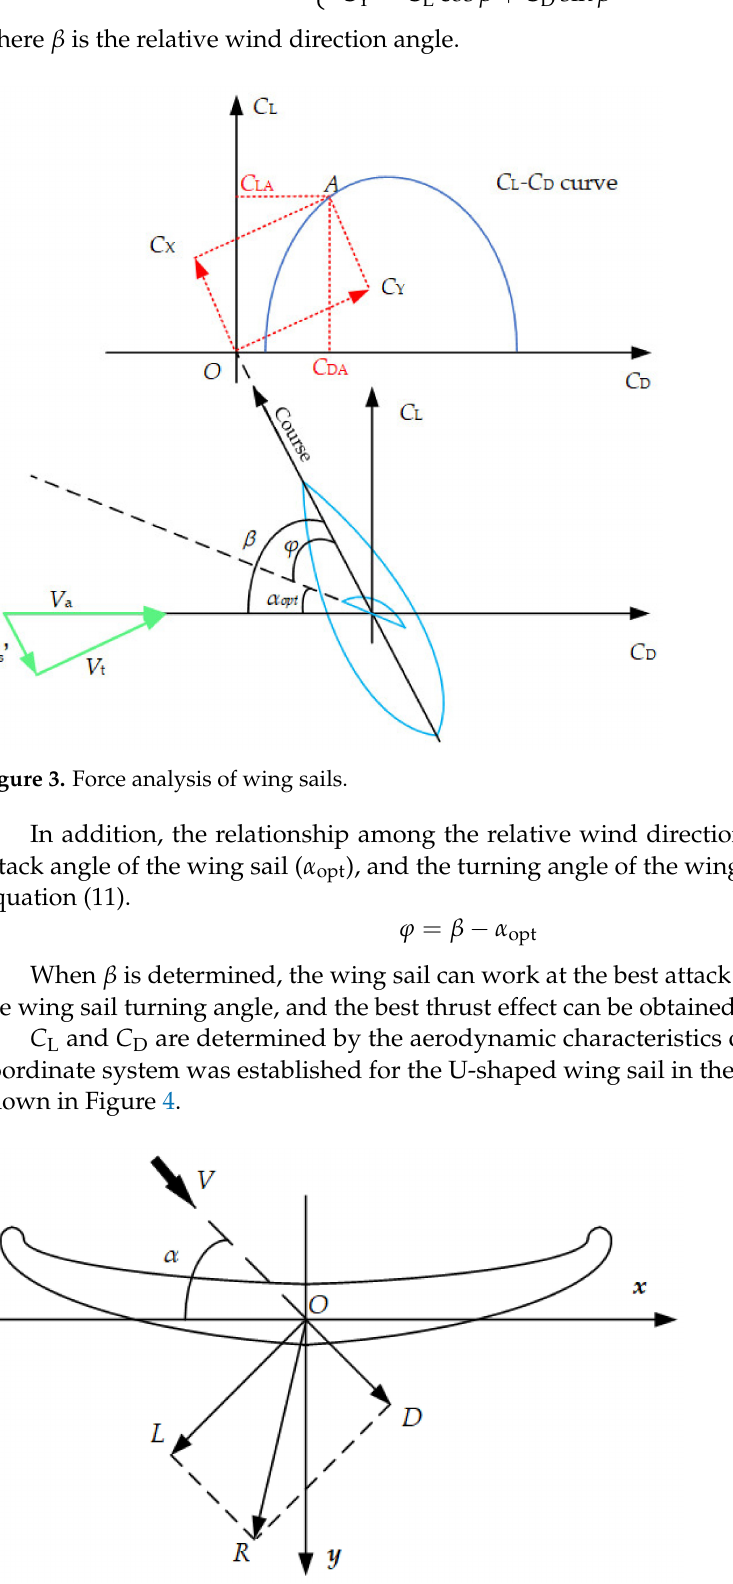
Figure 4. U-shaped wing coordinate system and force